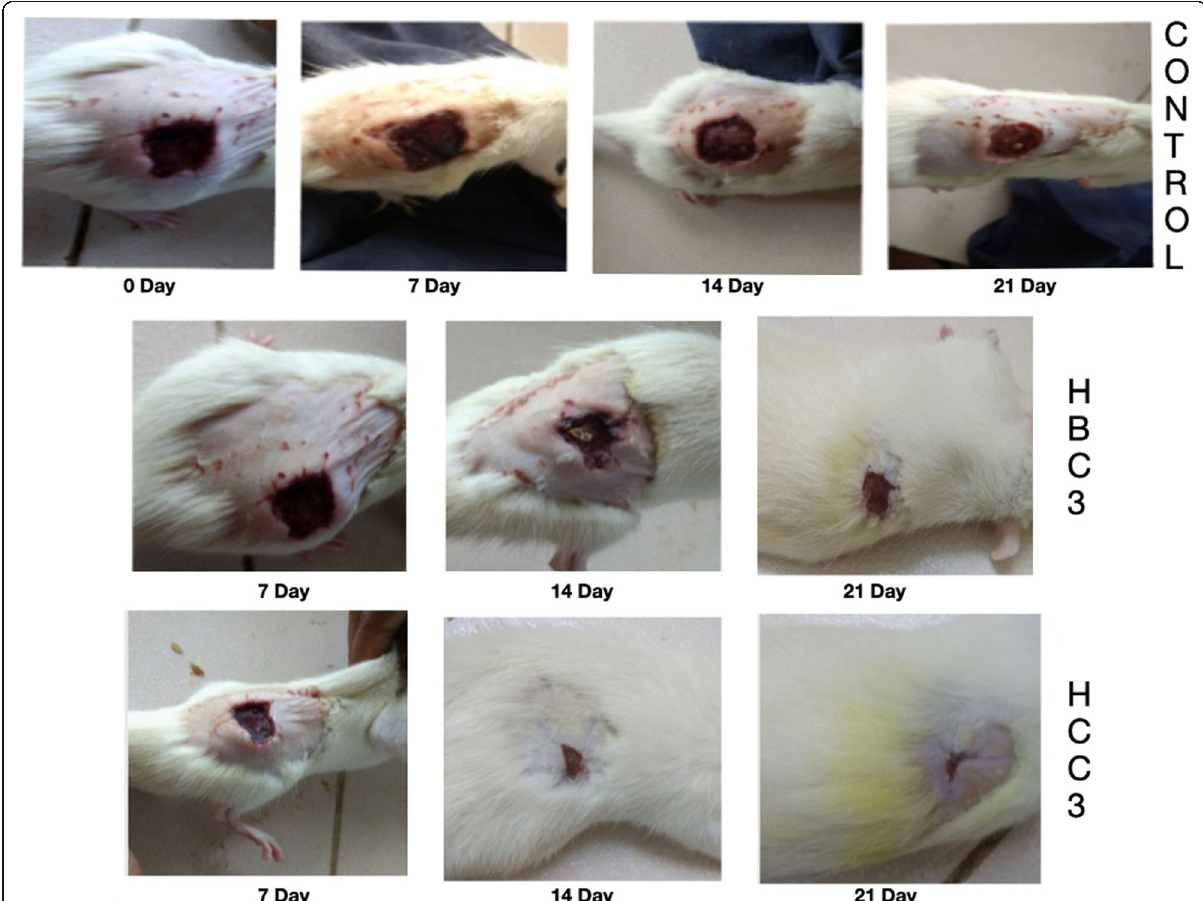
Fig. 6 Treatment of wounded animals with prepared bioscaffolds. Hbc3 containing 1.5 g of calcium chloride cross-linked with Hac1; Hcc3 containing 750 mg of atorvastatin loaded on